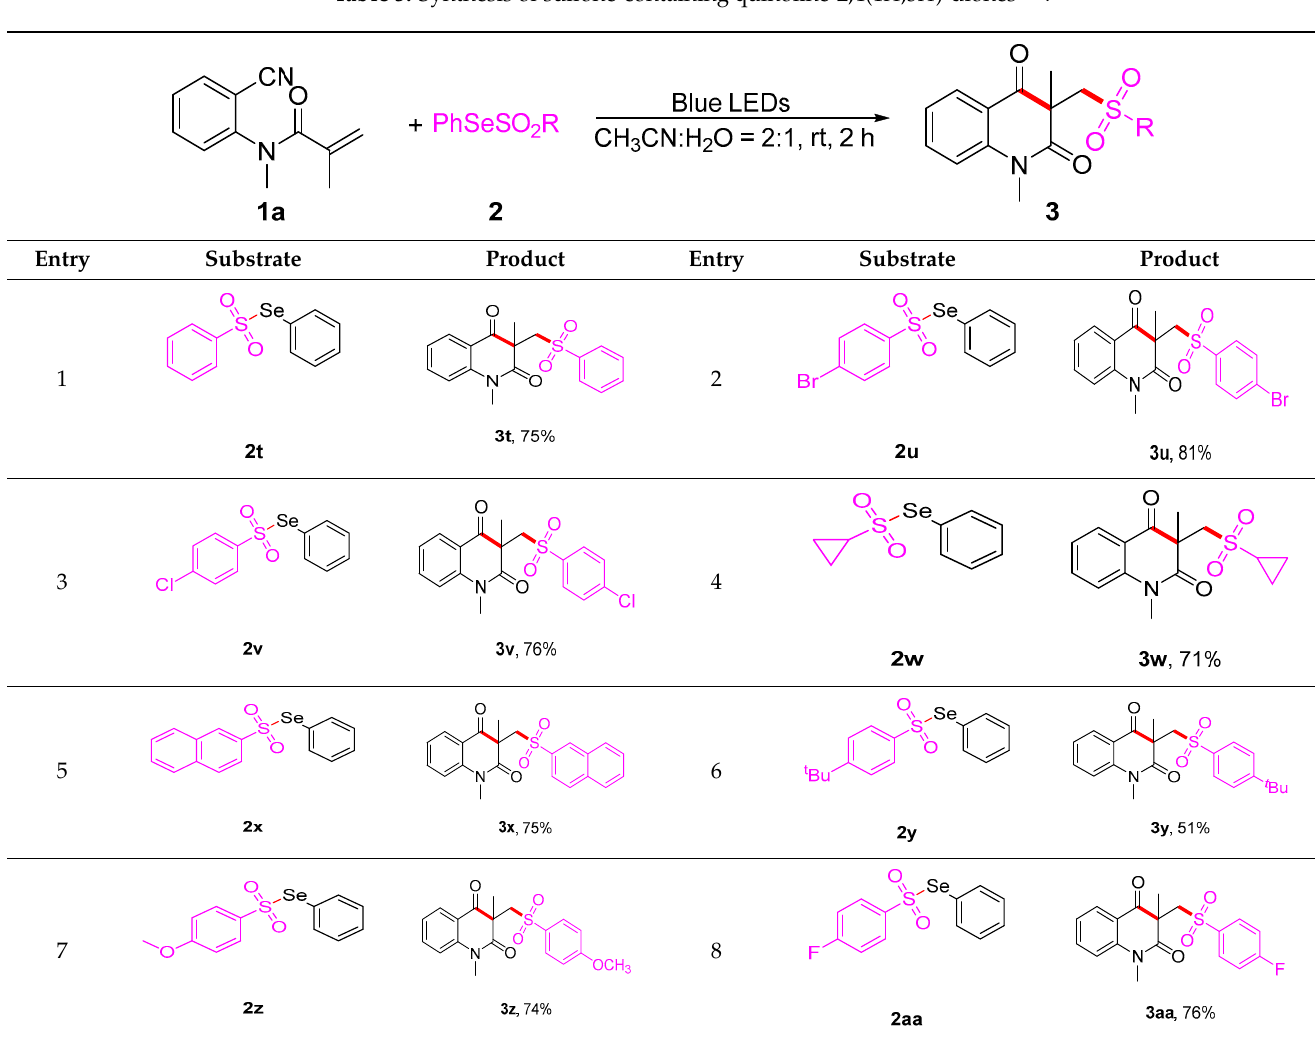
Table 3. Synthesis of sulfone-containing quinoline-2,4(1 H ,3 H )-diones a , b .